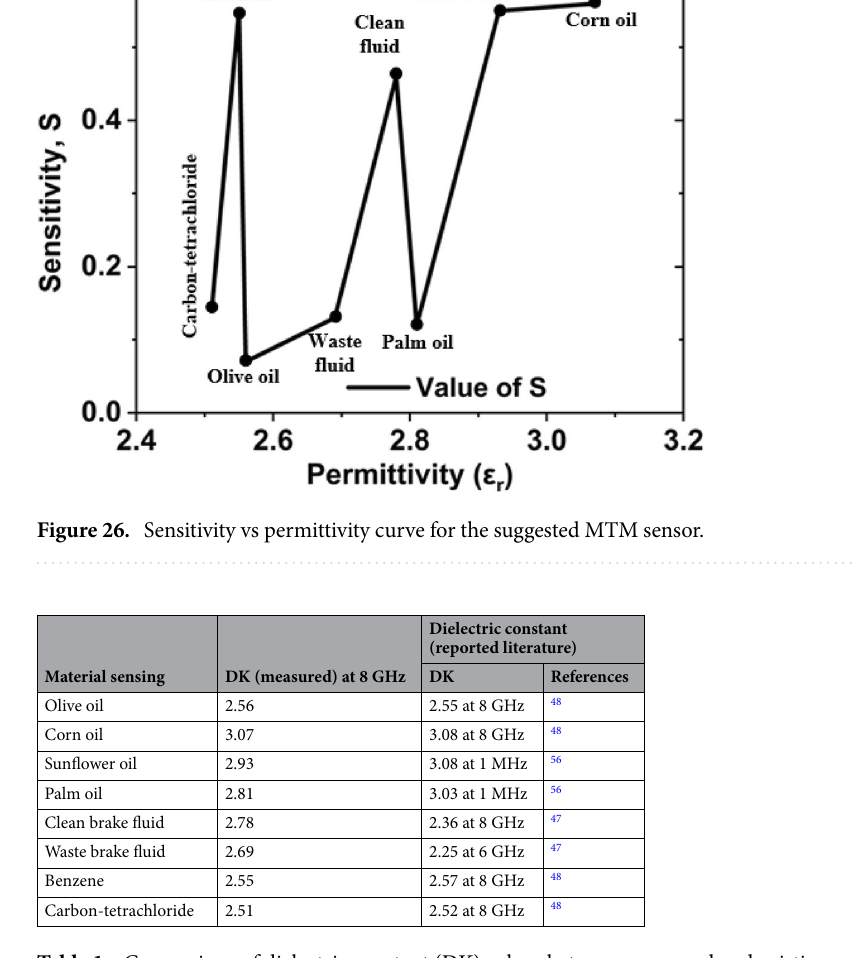
Table 1. Comparison of dielectric constant (DK) values between measured and existing works.